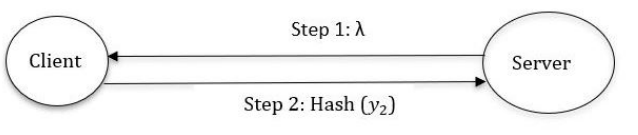
Figure 4. Diophantine authentication